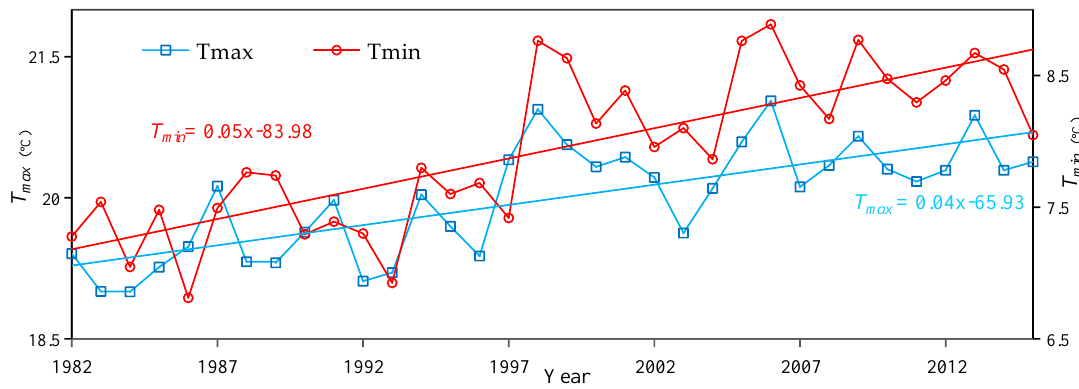
Figure 2. Variations of mean T max and T min during the growing seasons from 1982 to 2015 in the Yellow River Basin.